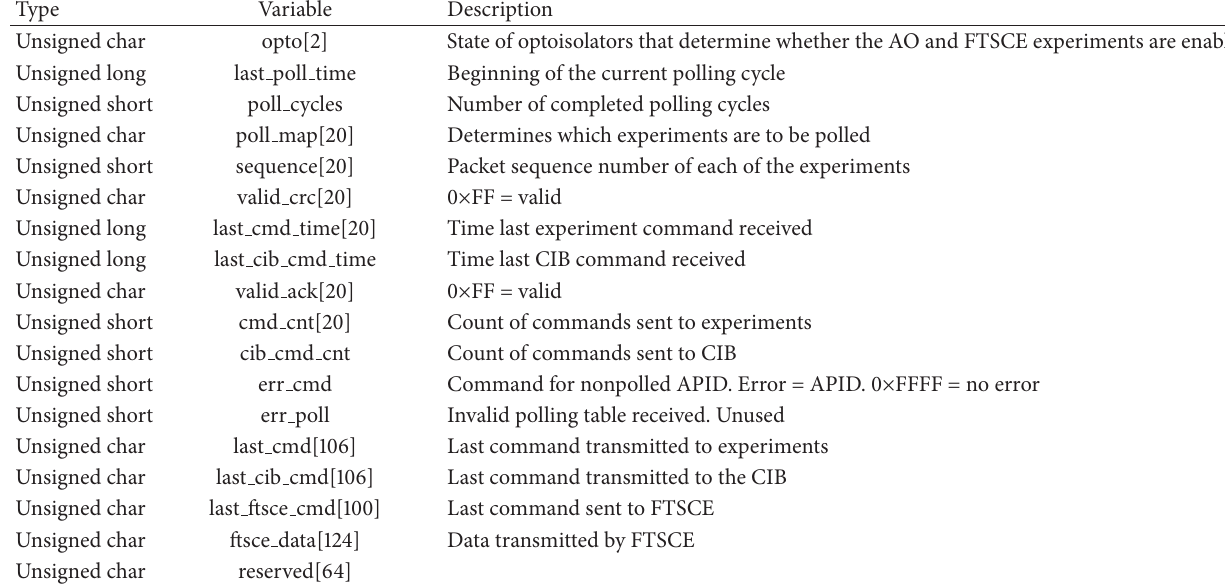
Table 1: Health and status packet format transmitted once per major frame (once per